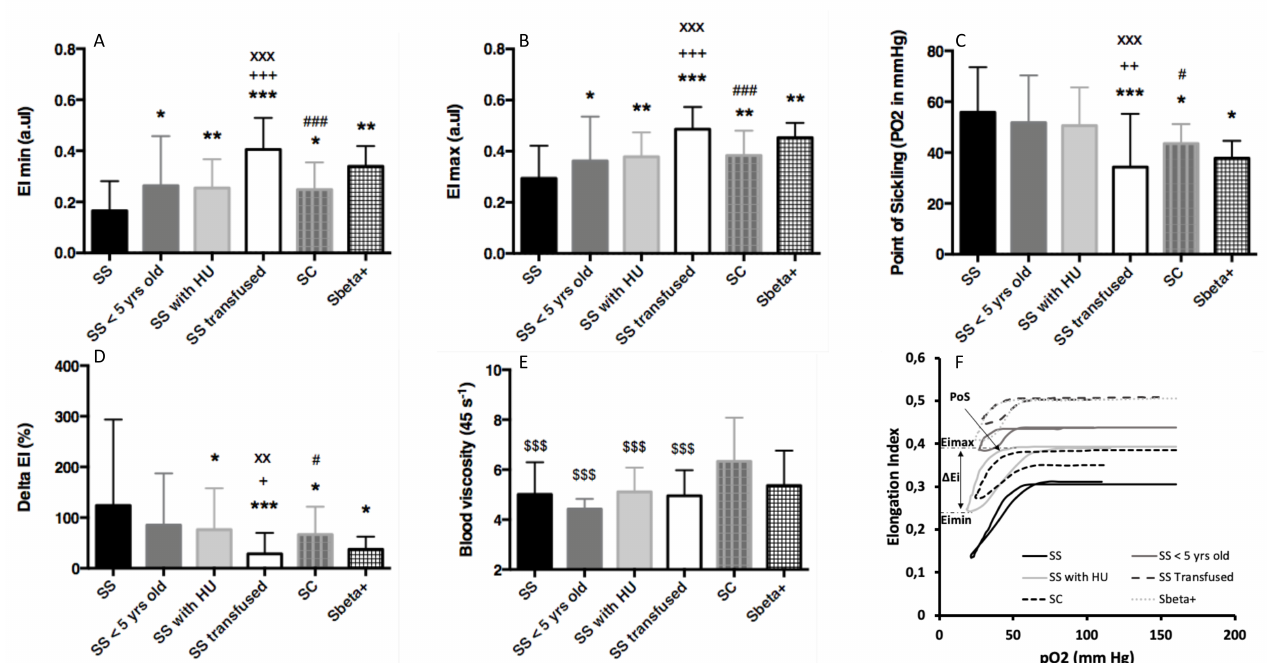
Figure 1. Comparisons of oxygen gradient ektacytometry parameters and blood viscosity between the 6 groups. ( A ) Min- imum RBC deformability (Emin); ( B ) Maximum RBC deformability (EImax); ( C ) Point of Sickling (PoS); ( D ) Difference between EImin and EImax (Delta-EI); ( E ) Blood viscosity at 45 s − 1 ; ( F ) Typical oxygenscan curves for the 6 populations tested. Compared to SS: * p < 0.05, ** p < 0.01, *** p < 0.001; different from SS < 5 years old: + p < 0.05, ++ p < 0.01, +++ p < 0.001; different from SS with HU: xx p < 0.01, xxx p < 0.001; different from SS transfused: # p < 0.05, ### p < 0.001; different from SC: $$$ p < 0.001. ( F ) Typical oxygenscan curves for the six populations and the different key point of the curves: the RBC deformability at deoxygenation (EImin), the RBC deformability at normoxia (EImax), point of sickling (PoS) and the difference between EImin and EImax (delta